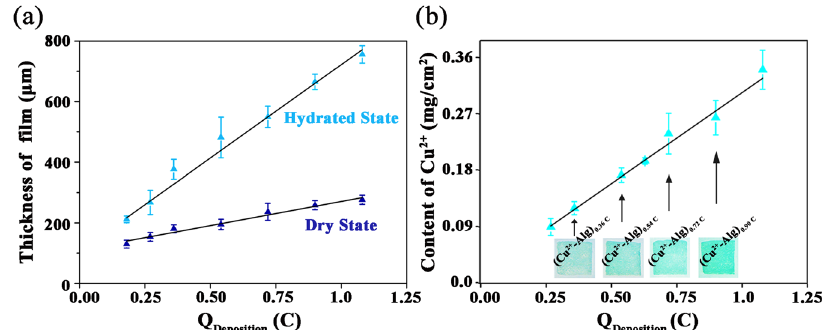
Fig. 2 The linear correlation between the fi lm thickness ( a ) and copper contents ( b ) with the consumed charges for Cu 2 + -Alg